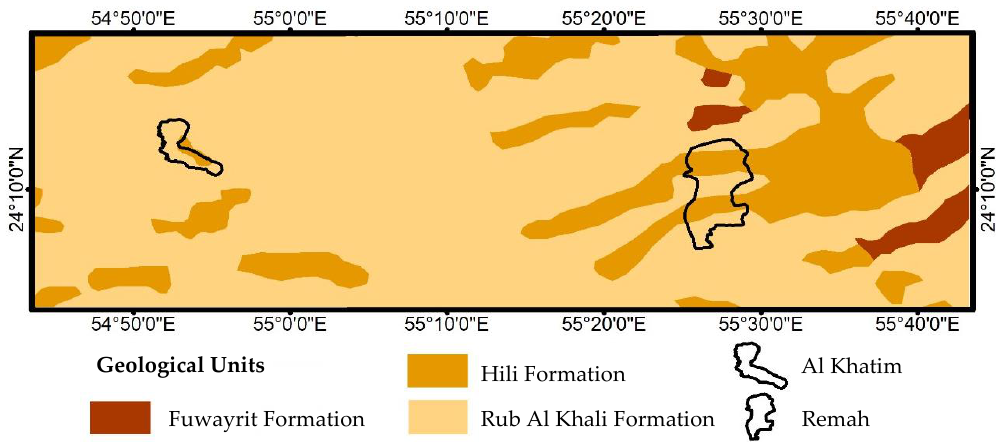
Figure 2. Geological map of the study areas showing geological formations in and around the study areas.